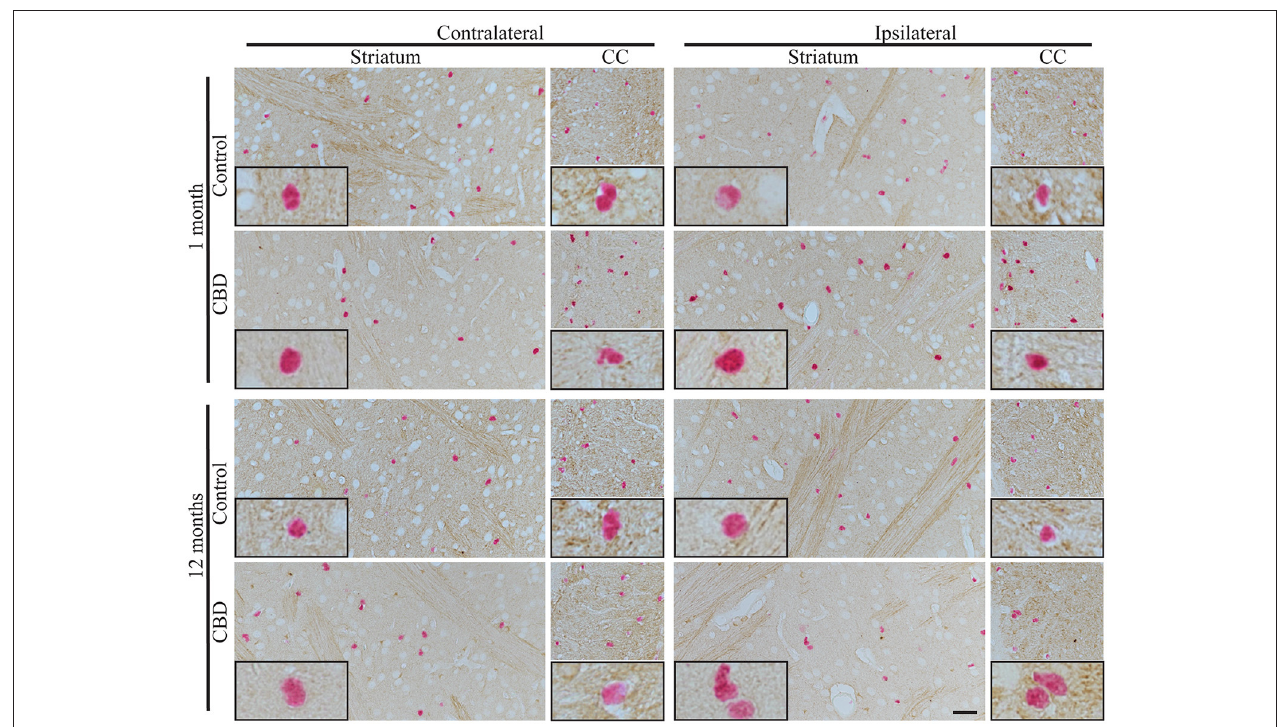
FIGURE 3 | The absence of tau pathology transmission in astrocytes. The microphotography pictures of double immunohistochemistry staining of tau phosphorylated at Ser202 (CP13 antibody, brown chromogen) in astrocytes (Sox9, nuclear marker, red/pink chromogen). The cell distribution in the contralateral (left panel) and ipsilateral side (right panel) of striatum (left subpanel) and corpus callous (right subpanel) after 1 month (upper panel) and 12 months (lower panel) of control-tau (upper subpanel) or CBD-tau (lower sub panel) inoculation. The representative pictures of cells in each group are presented as black-bordered inserts and demonstrate the absence of pathological tau in astrocytes in any of the experimental group at any time points, and similarly, the absence of pathological tau in neurons (morphological cell distinction) in any of the experimental group at any time points. The scale bar represents 50 µ m and applies to all pictures; the black-bordered inserts represent 4 × digital